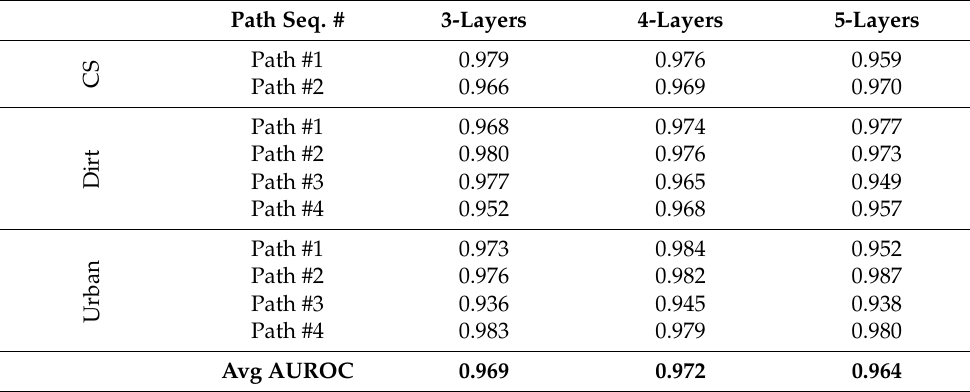
Table 2. Performance evaluation of detector D obtained by changing its number of layers. Reported scores refer to the AUROC